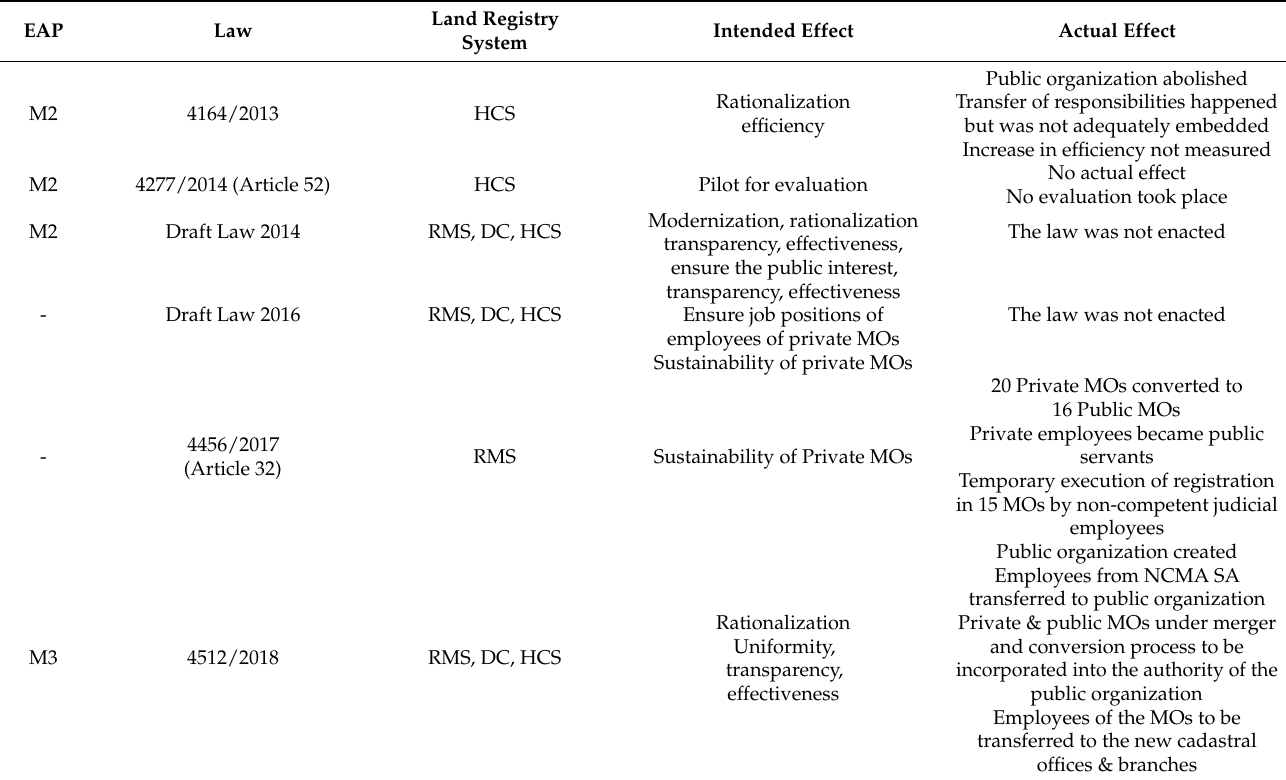
Table 1. Overview of legislative initiatives aimed at changing Greece’s LAOs from 2009 to